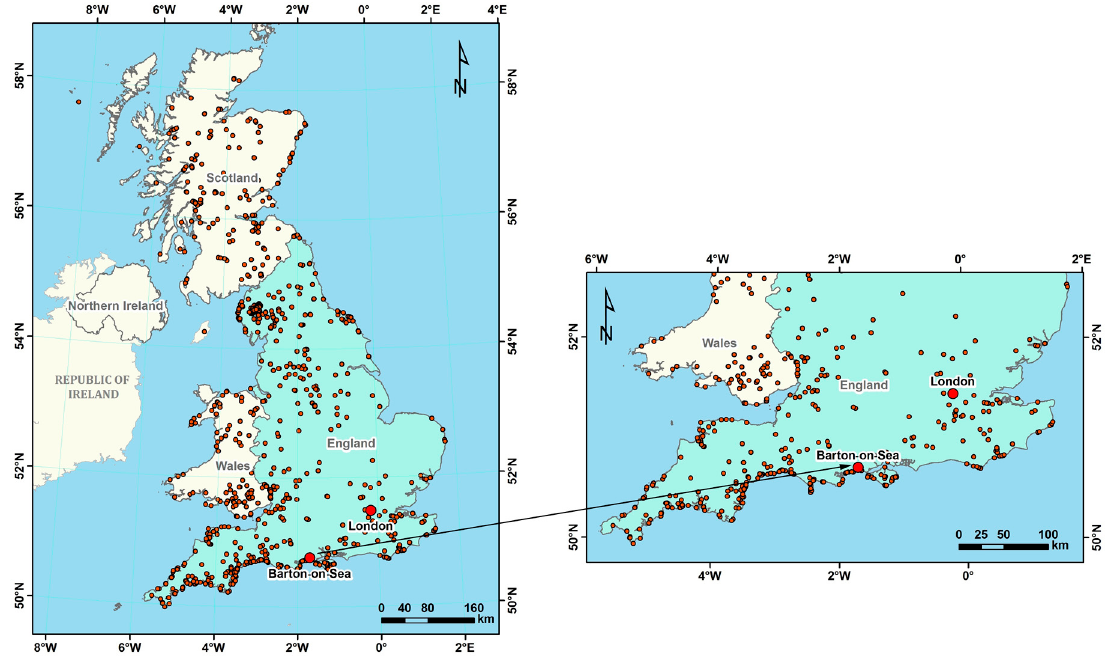
Figure 9. Landslide maps of the United Kingdom (UK) with south east coastal frontage as inset picture.